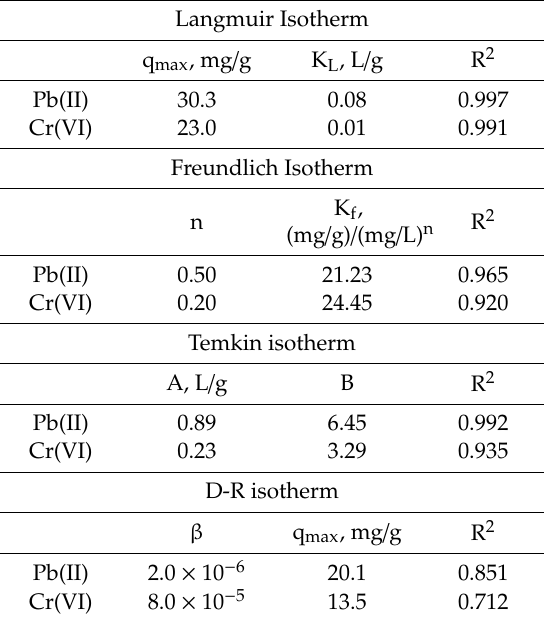
Table 1. Adsorption isotherm constants obtained from the four adsorption